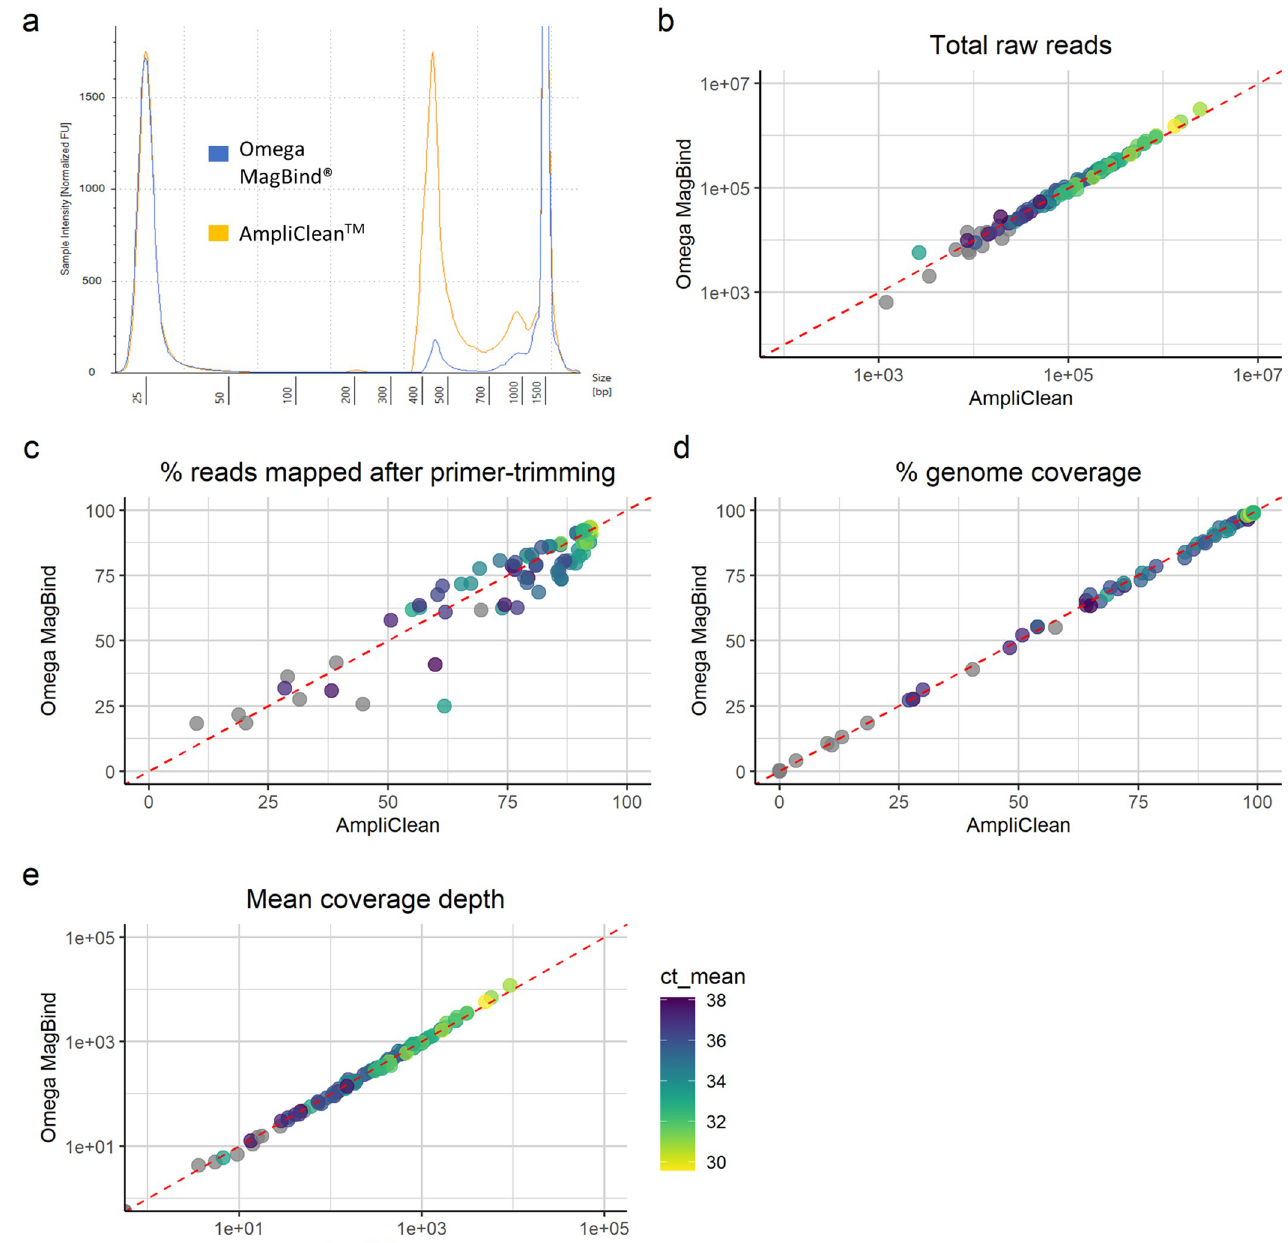
Fig 4. Post-PCR clean-up was effective with either Mag-Bind 1 TotalPure NGS or NimaGen AmpliClean TM beads. (a) Overlayed fragment size profiles of sequencing libraries purified in parallel with each bead type. Sequencing and alignment data, including total number of raw reads (a), percentage of raw reads mapping to SARS-CoV-2 genome after primer-trimming (b), percentage coverage breadth (c) and mean coverage depth (d), for each sample following purification with each bead type, with the colour of points representing the mean Ct value from SARS-CoV-2 RT-qPCR of the sample. https://doi.org/10.1371/journal.pone.0284211.g004 SARS-CoV-2 RNA concentration (Fig 5A), which is expected when post-PCR pooling is car- ried out without normalisation based on template concentration. Consequently, mean sequencing depth was also found to decrease at lower starting SARS-CoV-2 RNA concentra- tions (Fig 5B). All samples with concentrations � 160 gc/ μ l had a coverage breadth > 94%